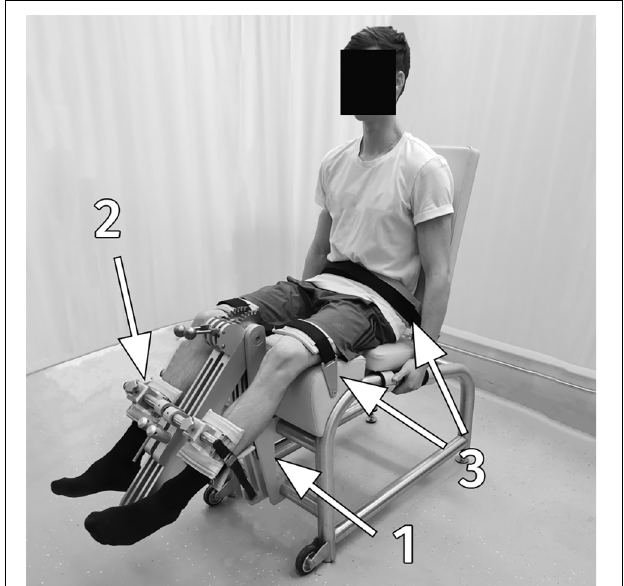
FIGURE 1 | Measurement setup; the subject in the isometric knee dynamometer: 1 , a strain gage force sensor; 2 , shank support; 3 , rigid straps for the pelvis and knee